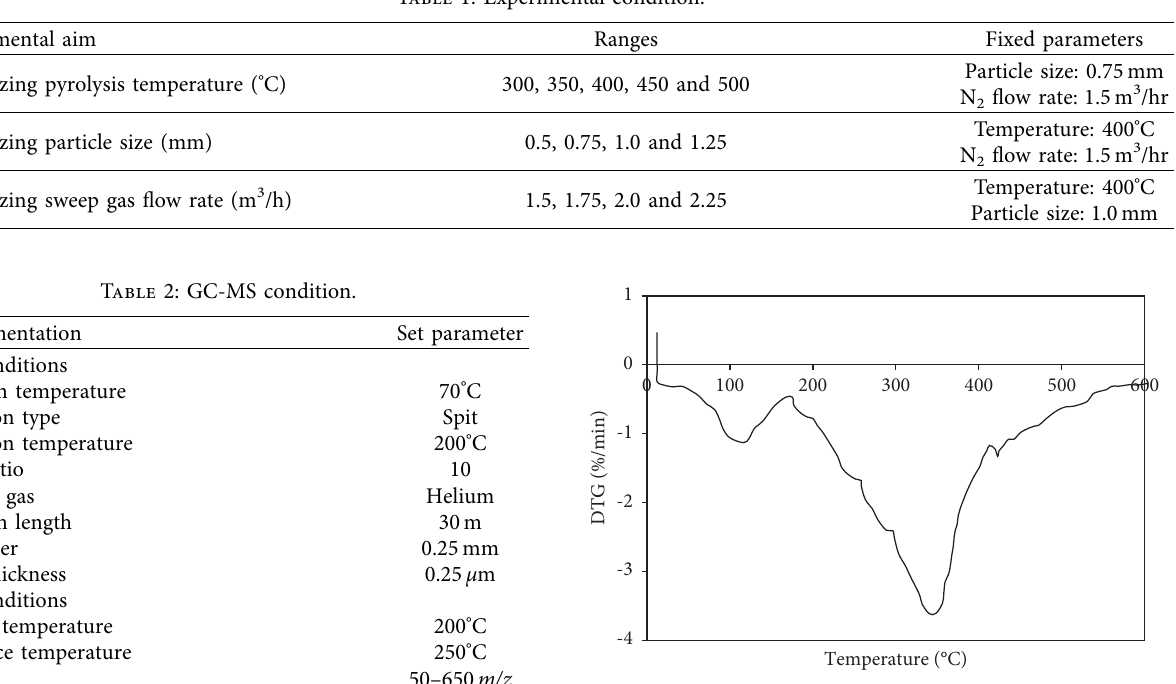
Figure 2: Derivative thermogravimetric